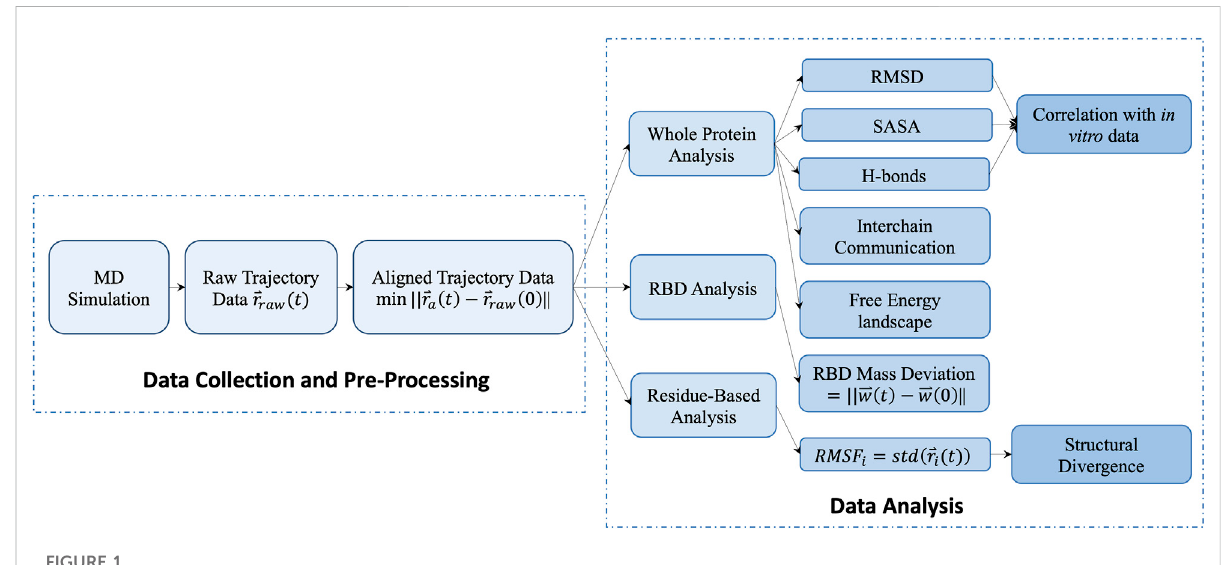
FIGURE 1 Data processing pipeline from collection to